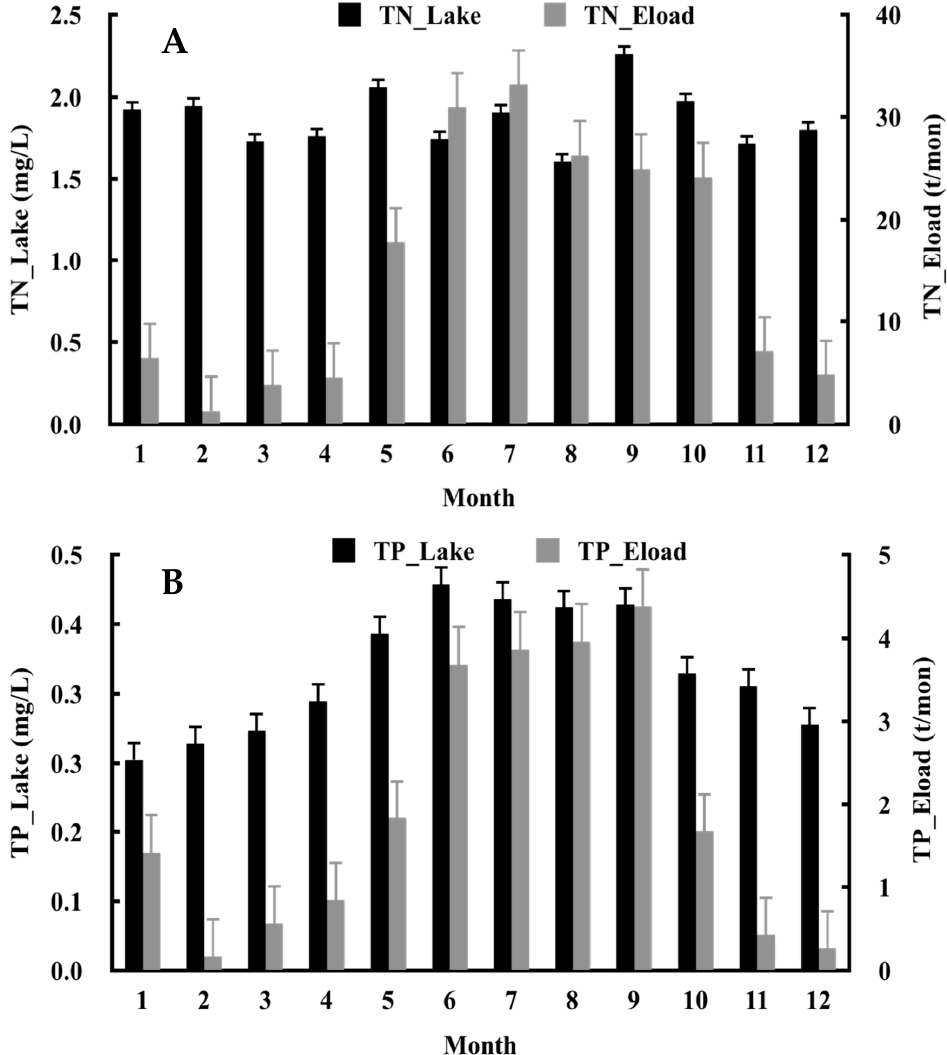
Figure 5. Mean monthly concentrations of lake TN (TN_Lake) with positive standard errors (black), and tributary loadings of TN (TN_Eload) with positive standard errors represented (grey) for January 2010–April 2018 ( A ). Mean monthly concentrations of lake TP (TP_Lake) with positive standard errors (black), and tributary loadings of TP (TP_Eload) with positive standard errors represented (grey) ( B ) for January 2010–April